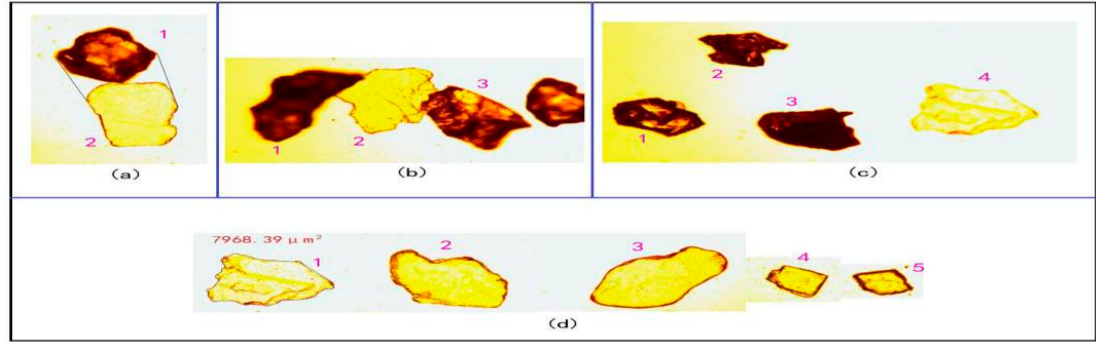
Figure 7. Distribution of particle characteristics (×1 k).